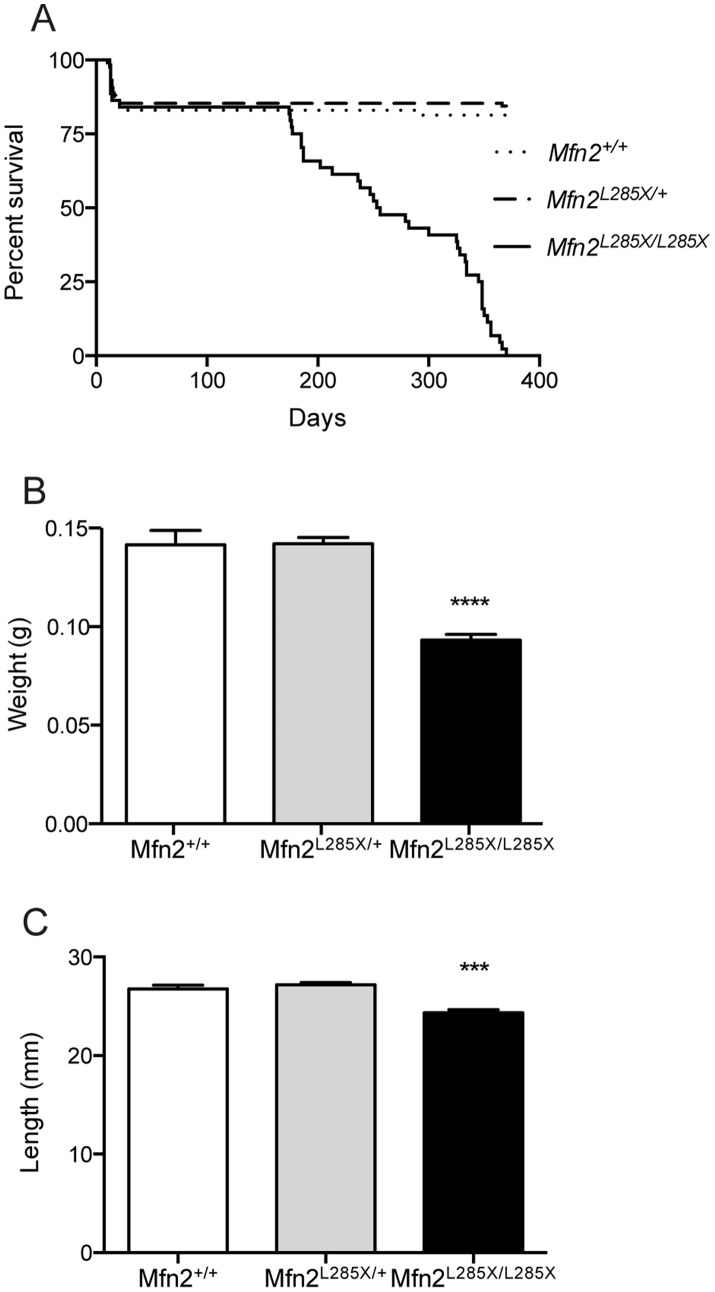
Characterisation of the phenotype of adult MFN2L285X mutant zebrafish.(A) Survival curve showing loss of viability of MFN2L285X/L285X zebrafish from 170 days onwards (p<0.0001, Log-rank (Mantel-Cox) test). (B) Bar graph of body weight for all three groups of siblings at 60–70 days old (p<0.0001, Kruskal-Wallis with Dunn’s multiple comparisons test). (C) Bar graph of the nose to tail length of MFN2L285X mutant and sibling zebrafish at 60–70 days old (p<0.001, Kruskal-Wallis with Dunn’s multiple comparisons test).